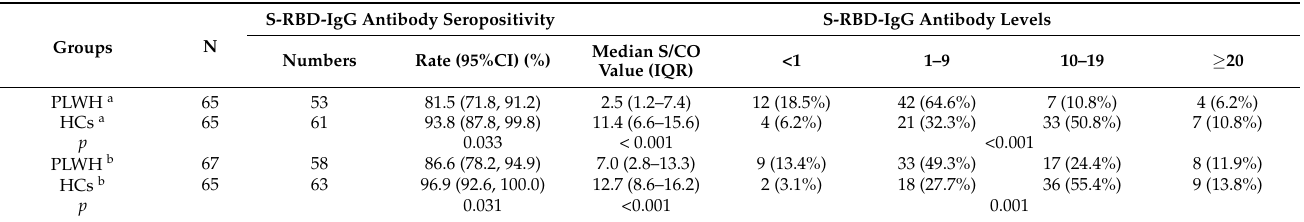
Table 3. The S-RBD-IgG antibody data for the first blood collection after PLWH and HCs received two doses of BBIBP-CorV vaccine or CoronaVac vaccine (N =